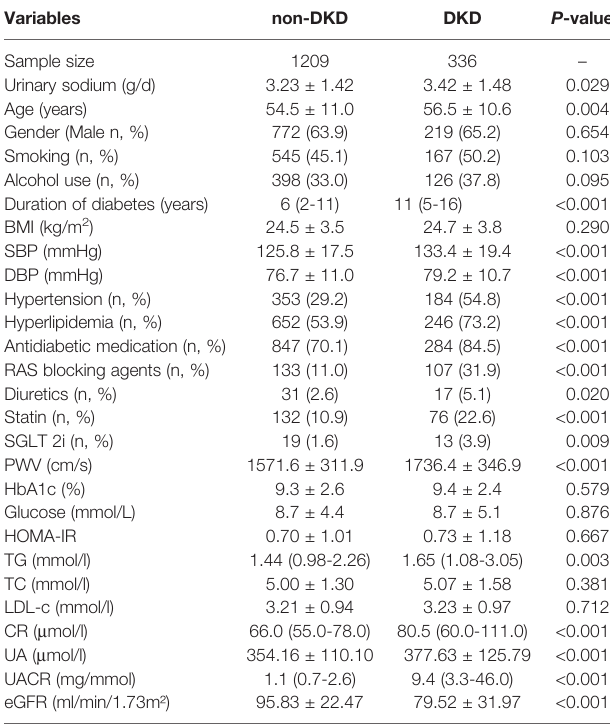
TABLE 1 | Characteristics of patients categorized by presence of